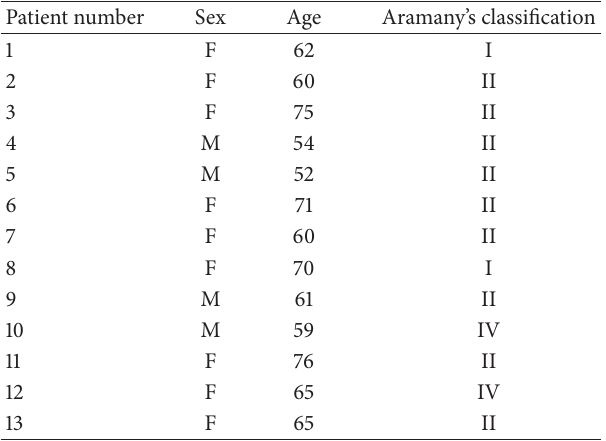
Figure 1: Spectrograms of normal and atypical production of stop consonants. (I) Spectrogram of a normally produced stop voiceless consonant, where A is the consonant burst and B is vocal fold vibration. (IIA) Spectrogram of a consonant showing a negative VOT, where C is a consonant burst and D is vocal fold vibration that started earlier than the consonant onset. (IIB) Spectrogram with an unclear consonant onset (E). Table 1: Patient